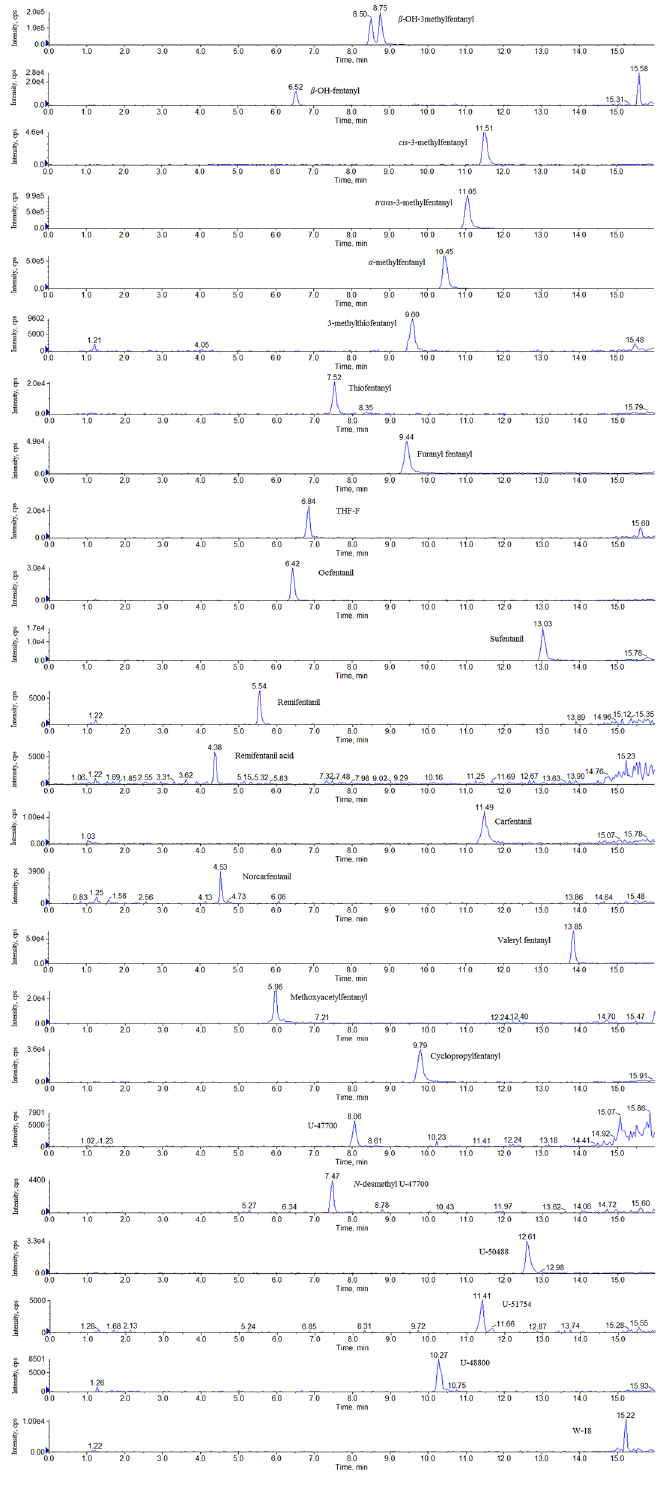
Figure 2. MRM chromatograms for the 37 analytes in hair samples spiked at the LOQ